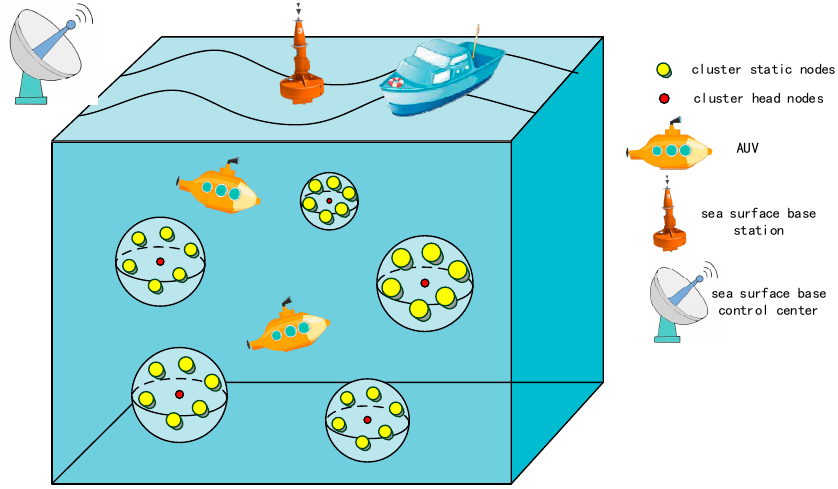
Figure 1. Multi-AUVs data acquisition system.